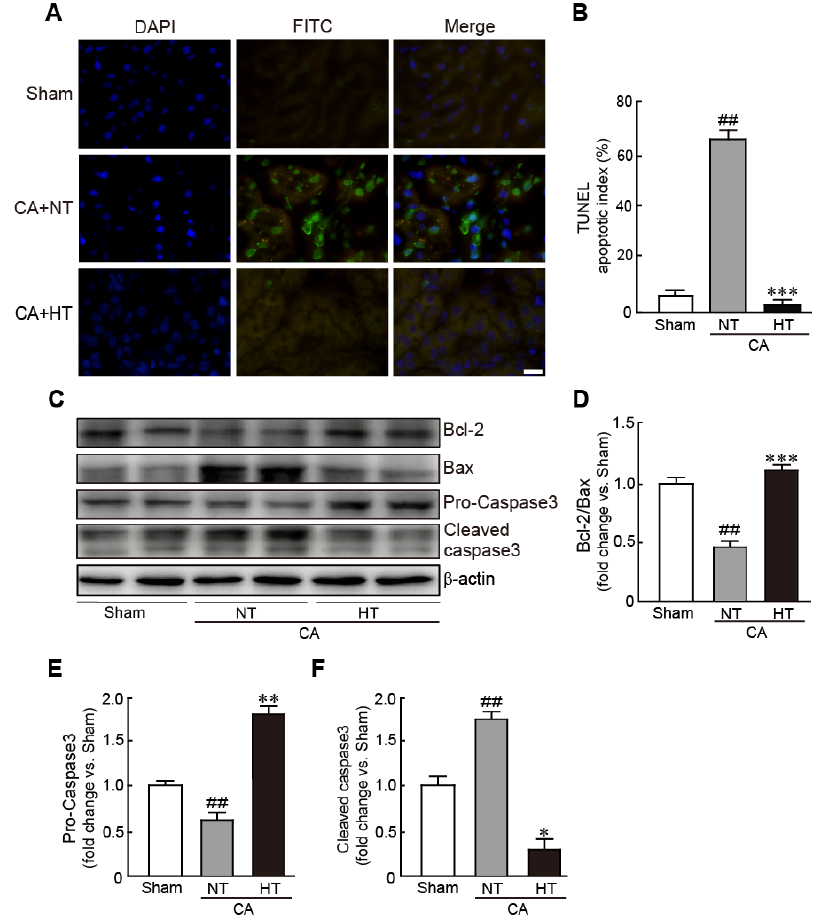
Figure 4. Olanzapine-induced TH inhibits CA-induced apoptotic cell death in renal tissues. ( A ) Representative photographs of TUNEL staining of rat tissues after CA and ROSC with or without olanzapine-induced TH. The apoptotic index ( B ) was determined by calculating the percentages of TUNEL-positive and total cells. ( C – F ) Western blot analysis for the expression of Bcl-2, Bax, pro-caspase 3, cleaved caspase 3, and β -actin proteins in renal tissues after CA and ROSC with or without olanzapine-induced TH ( n = 3 per group). Significance is represented as ## p < 0.01 vs. the sham group; * p < 0.05, ** p < 0.01, and *** p < 0.001 vs. the CA + NT group. CA, cardiac arrest;